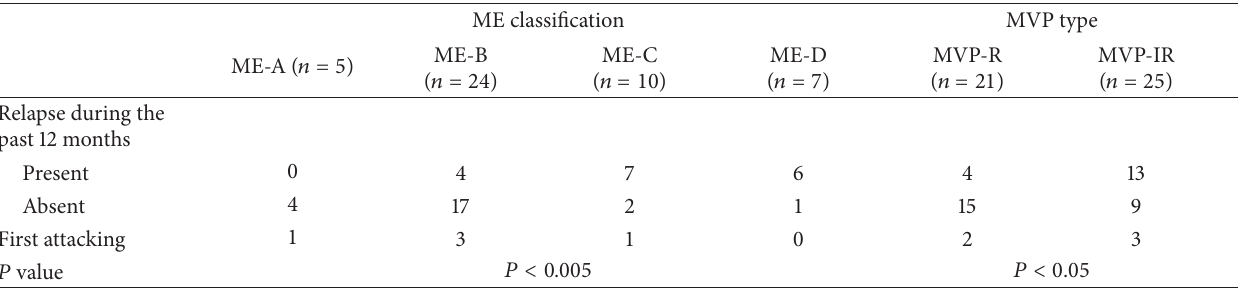
Table 5: The episode of disease relapse during the past 12 months among the ME (magnifying endoscopic) classifications and between the MVP (microvascular pattern) types of patients with ulcerative